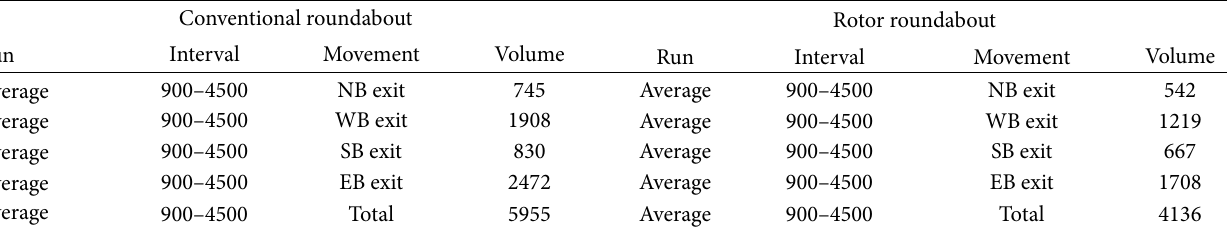
Table 8: Maximum throughput (alternative design